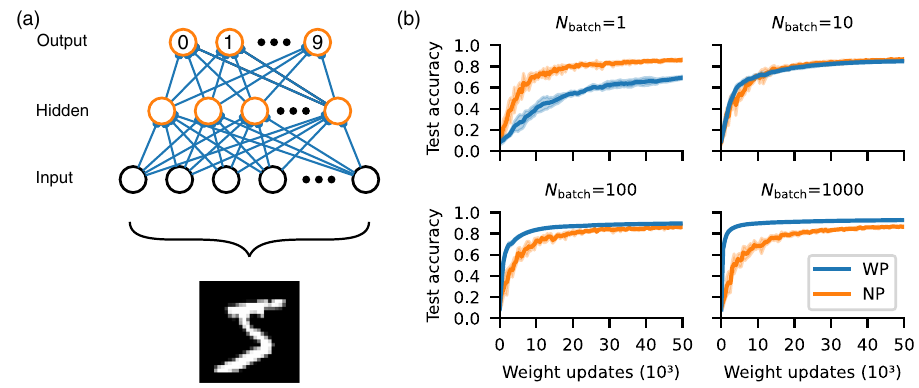
FIG. 9. WP can outperform NP on MNIST. (a) Schematic of the used fully connected, two-layer network. All network weights are learned; i.e., for WP all network weights (blue) are perturbed, and for NP all network nodes (orange) are perturbed. (b) Test accuracy as a function of the number of weight updates for WP (blue) and NP (orange) for different batch sizes. NP does not profit from increasing the batch size and always reaches a final accuracy of approximately 86%. WP improves considerably with increasing batch sizes and 1000 . Solid lines show the mean, and shaded areas show the standard reaches a final accuracy of approximately 92% for N batch ¼ deviation using five network